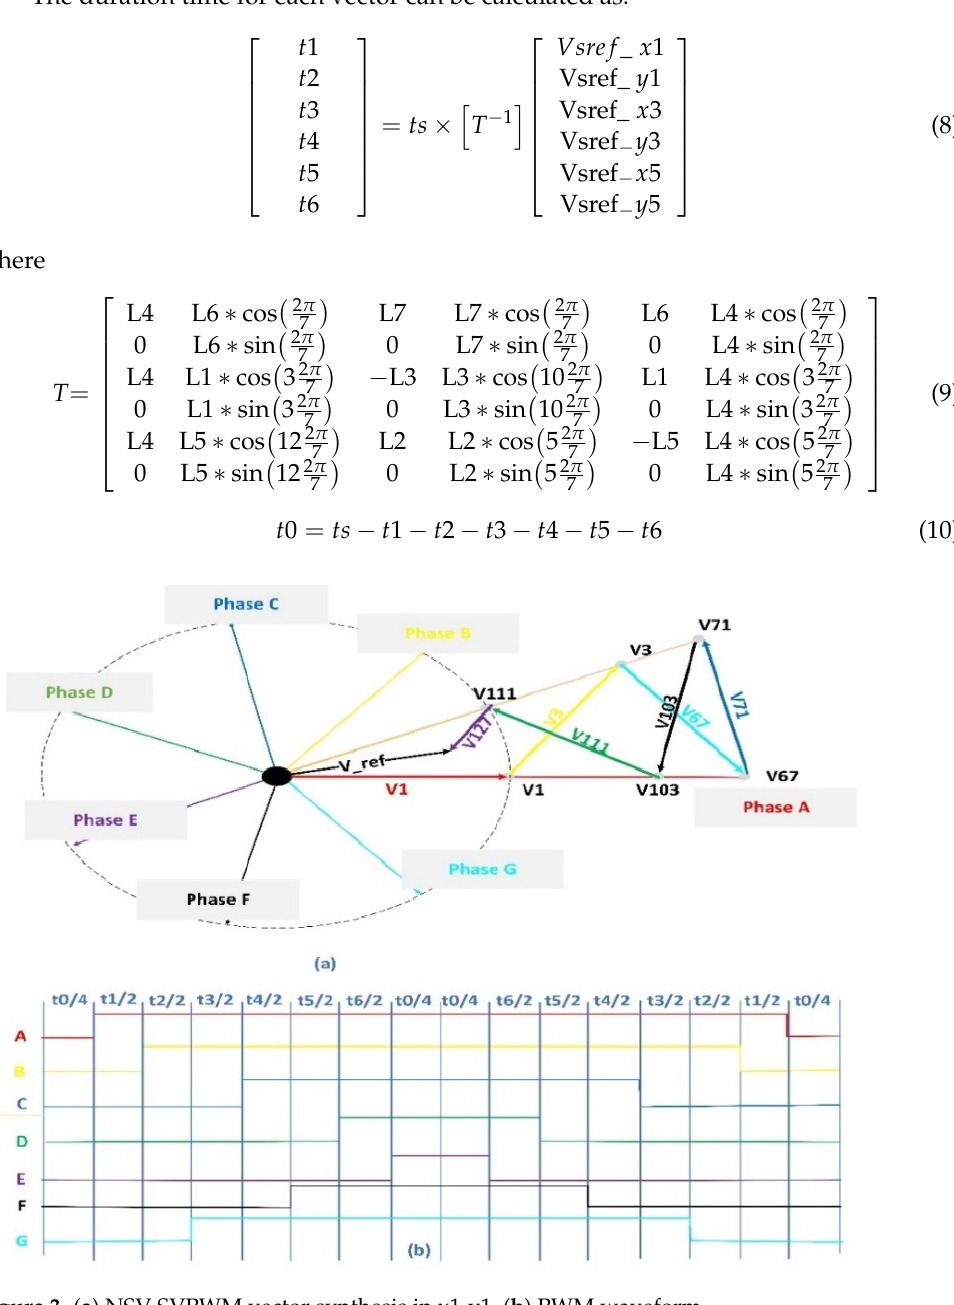
Figure 3. ( a ) NSV-SVPWM vector synthesis in x1-y1, ( b ) PWM waveform.